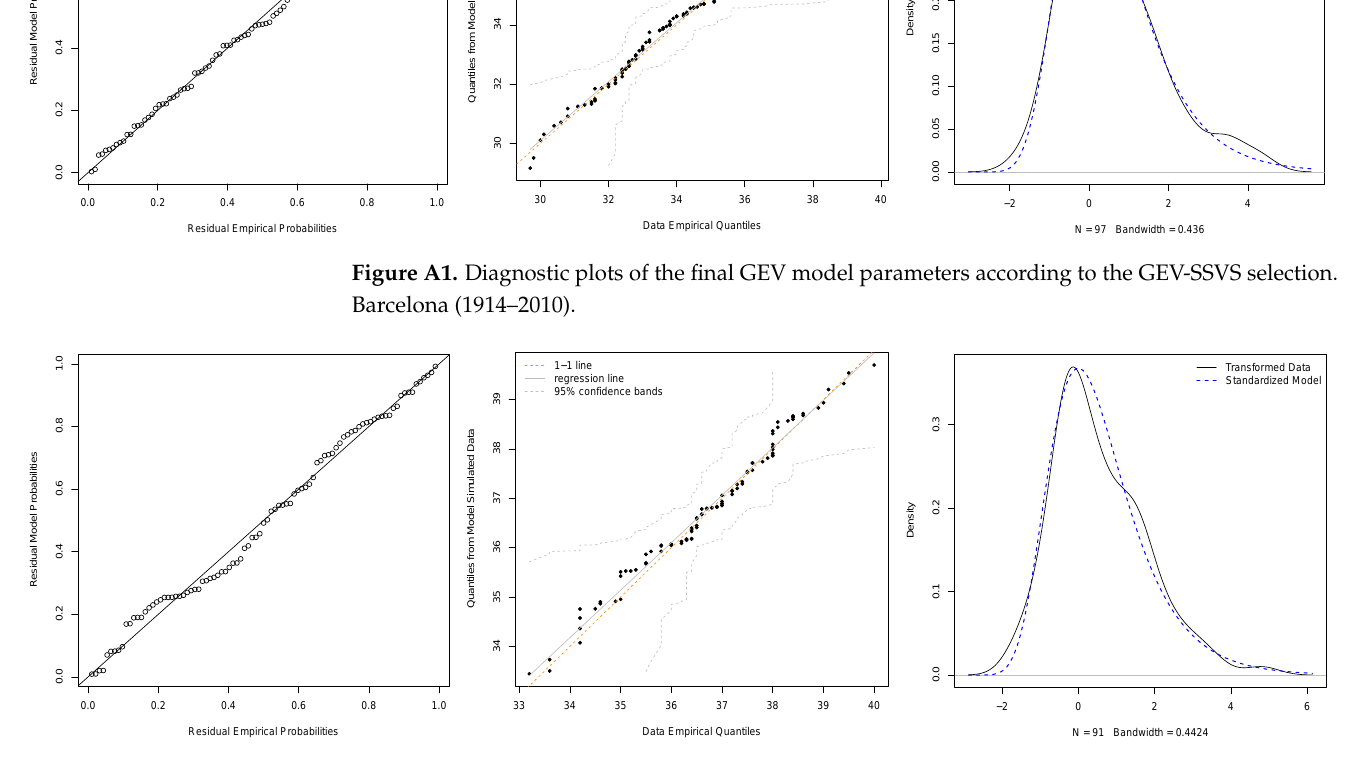
Figure A2. Diagnostic plots of the final GEV model parameters according to the GEV-SSVS selection. Madrid (1920–2010).